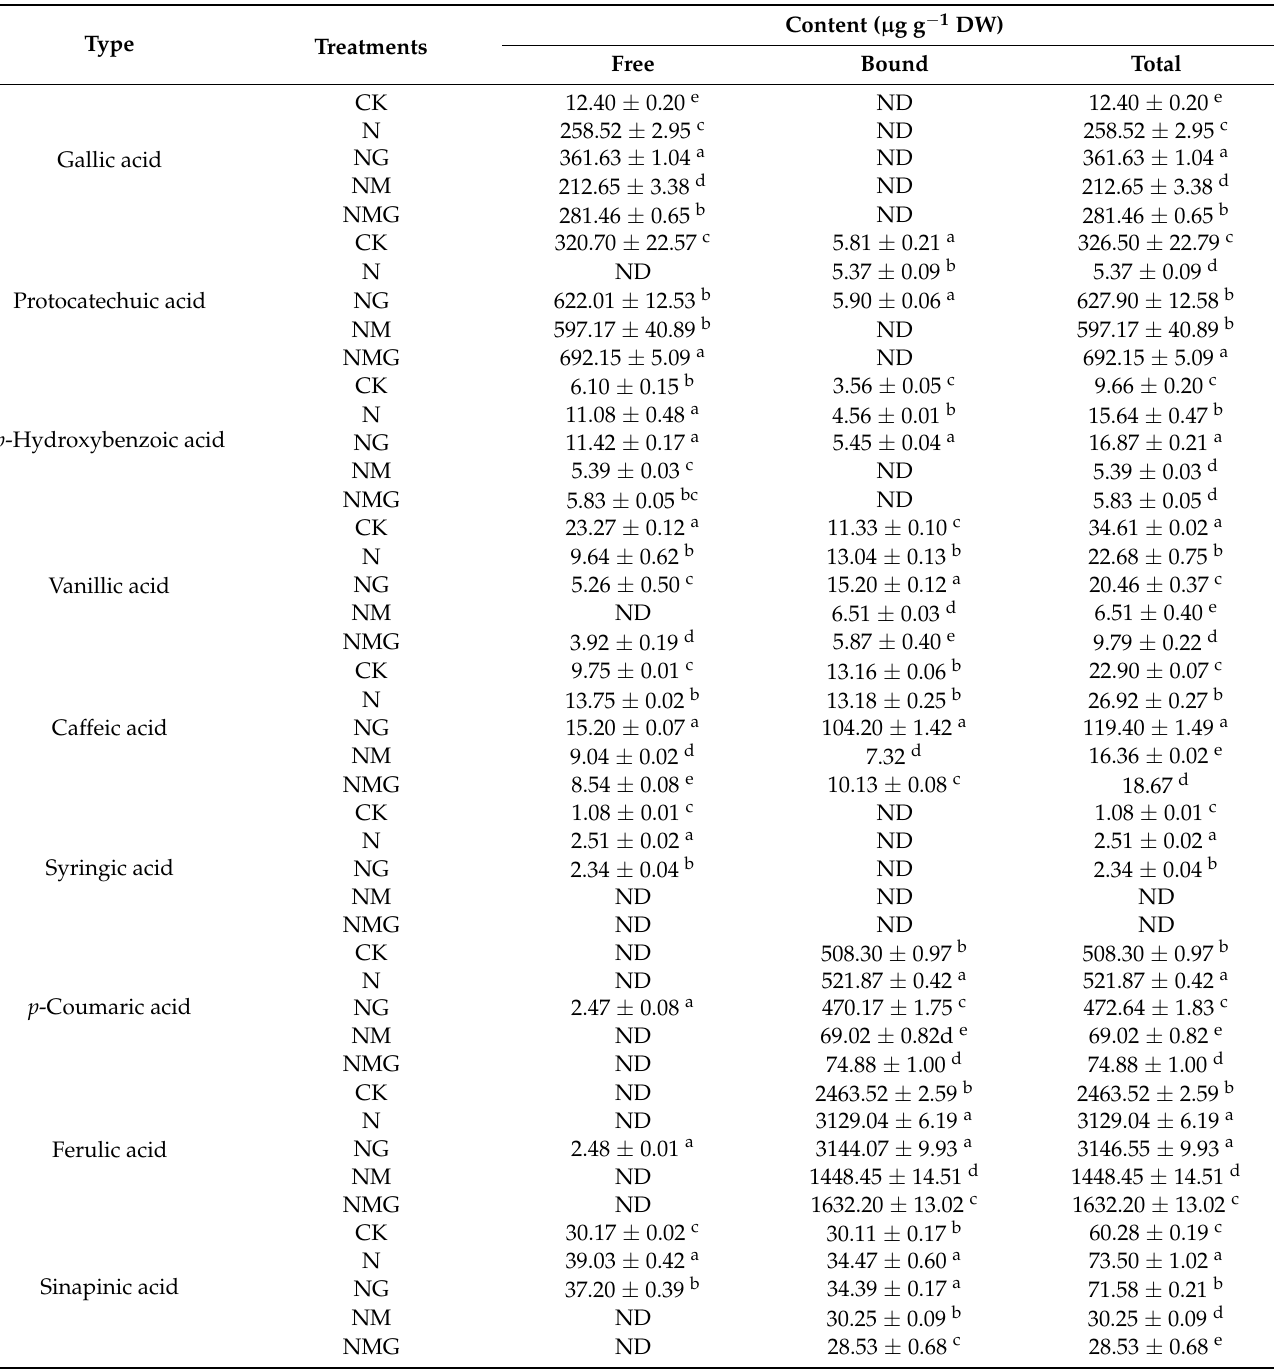
The individual phenolic acid content of 6-day-old barley seedlings is presented here. The lower case letters in the same column for each phenolic acid indicate significant differences at p < 0.05 among different treatments. One-way ANOVA was used. ND means “not detectable”. The data are presented as mean ± SD, n ≥